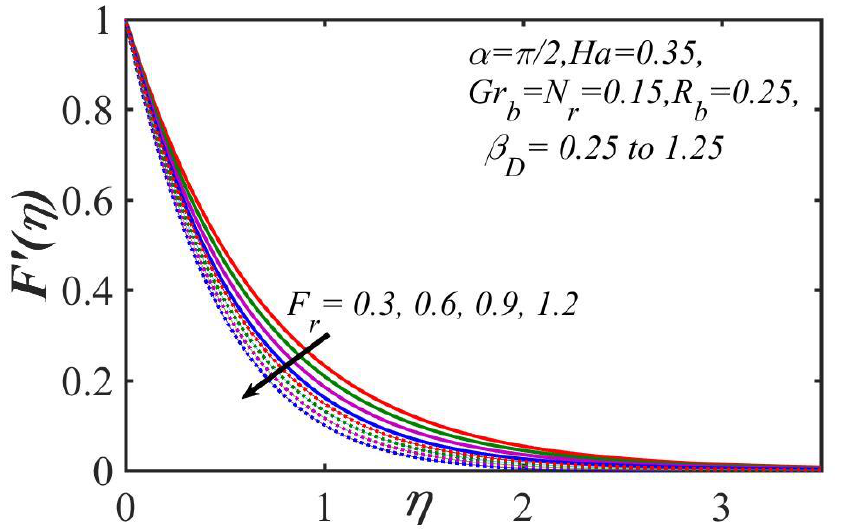
Figure 2. Variation of 𝑆 and 𝐻𝑎 over velocity magnitudes. Solid curve: 𝐻𝑎 = 0 ; dotted curve: 𝐻𝑎 = 0.5 .